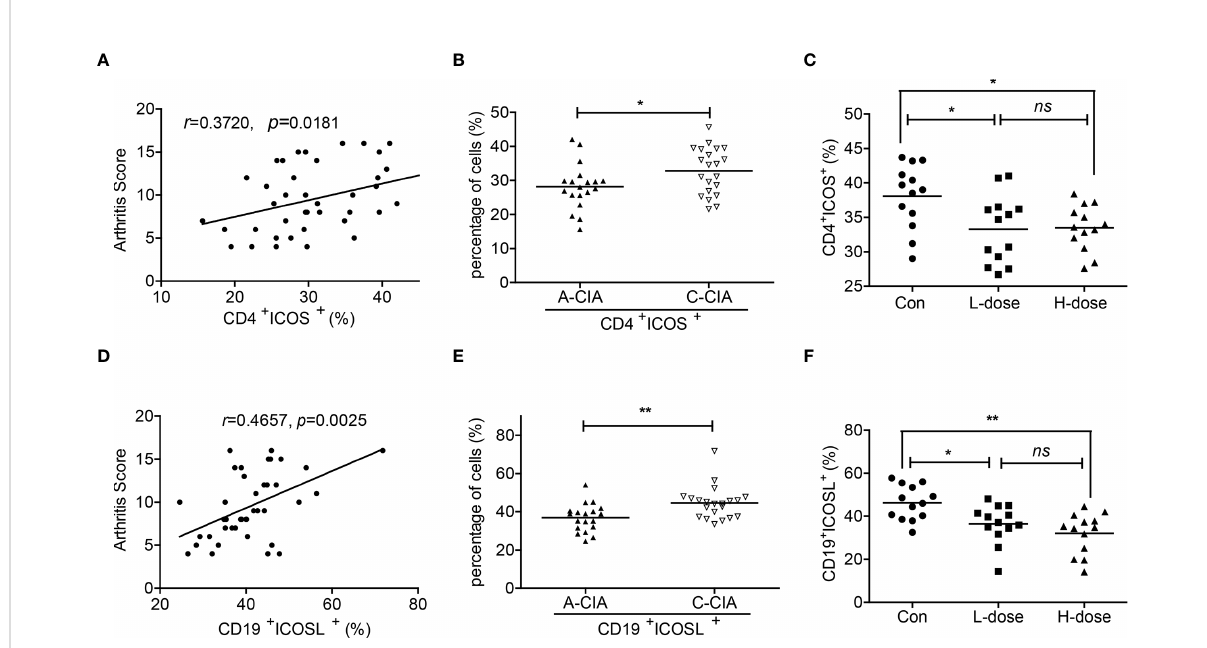
FIGURE 4 Correlations between CD19 + ICOSL + B cells and clinicopathological characteristics of CIA mice. (A) Correlation between the percentage of CD4 + ICOS + T cells and the arthritis scores of CIA mice (n = 40). (B) The percentage of CD4 + ICOS + T cells in A-CIA (n = 19) and C-CIA (n = 21) mice. (C) The percentage of CD4 + ICOS + T cells in CIA mice treated with the L-dose (n = 13), H-dose (n = 13) of Dex or PBS (n = 13). (D) Correlation between the percentage of CD19 + ICOSL + B cells and the arthritis score of CIA mice (n = 40). (E) The percentage of CD19 + ICOSL + B cells in A-CIA (n = 19) and C-CIA (n = 21) mice. (F) The percentage of CD19 + ICOSL + B cells in CIA mice treated with the L-dose (n = 13), H-dose (n = 13) of Dex or PBS (n = 13). Each data point represents an individual subject; horizontal lines represent means; the r value indicates Spearman ’ s correlation coef fi cient; * P < 0.05, ** P < 0.01, ns = not signi fi cant.